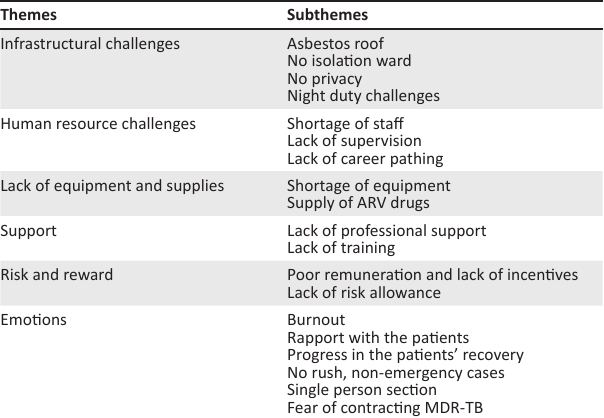
TABLE 2: Themes and